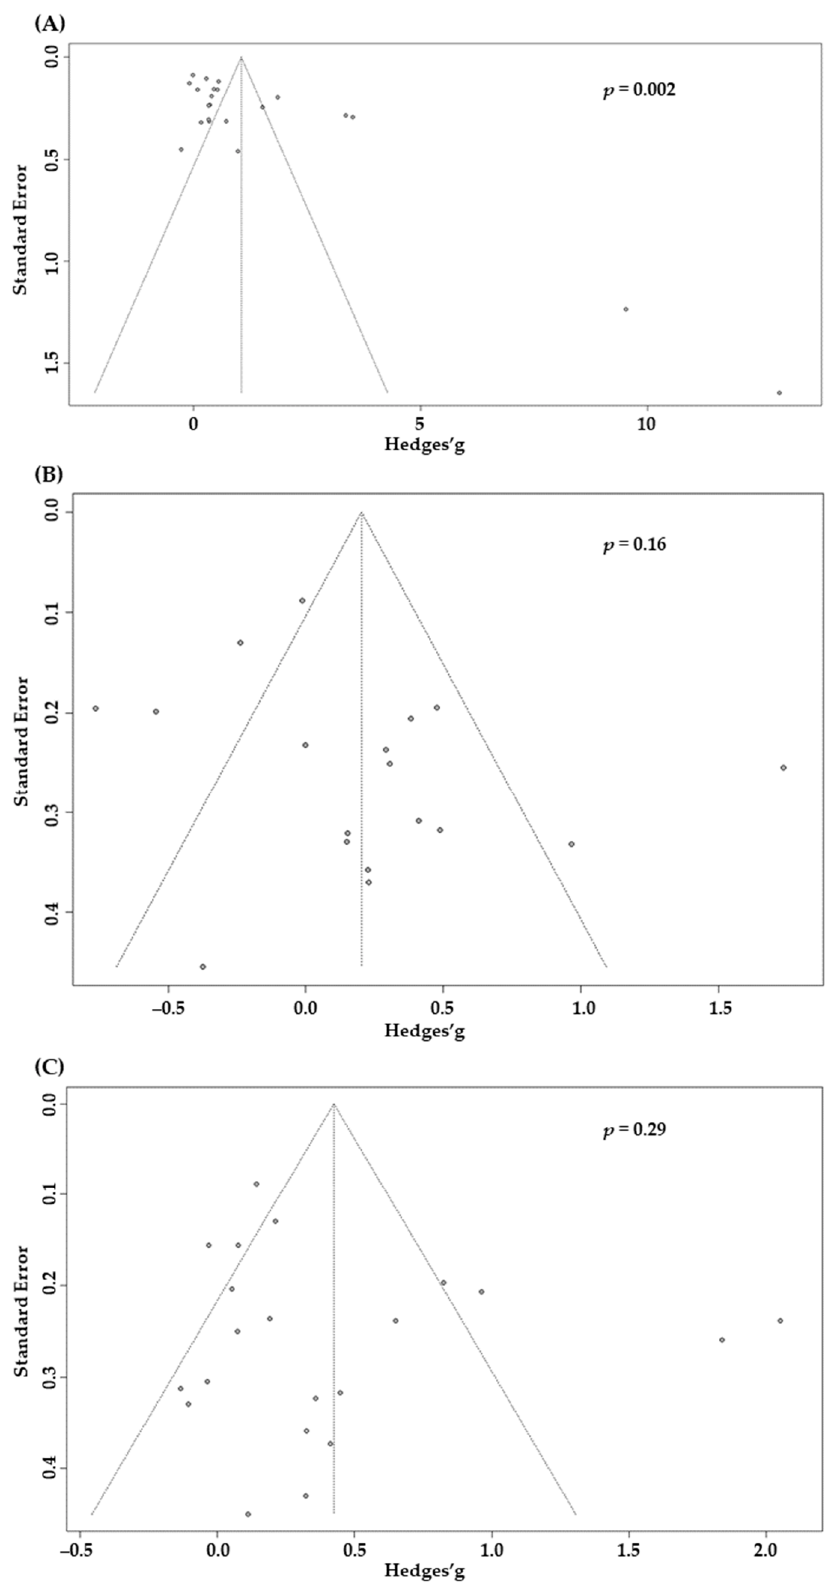
Figure A2. Funnel plots and p -values obtained from Egger’s test in meta-analyses for the effects of physical exercise on three HRQOL domains in office workers. ( A ) General; ( B) physical; and ( C ) mental. HRQOL = health-related quality of life.